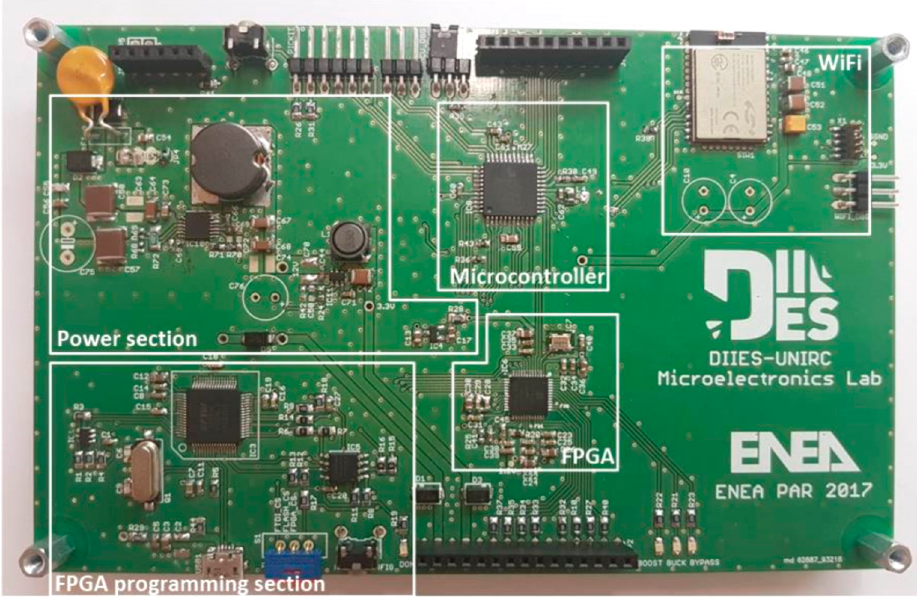
Figure 4. Main logic board top view.